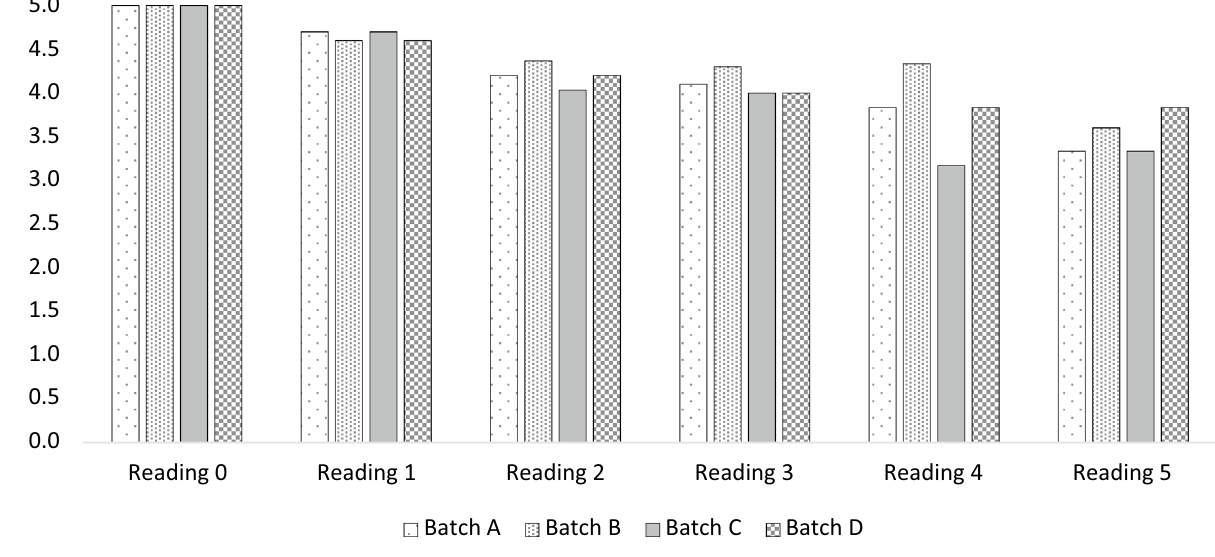
Figure 6. Weekly sensory evaluation of mango fruit exposed to four different treatments ( A negative control non-treated fruit; B PJ-WS-LE extract at 8 g L −1 was used to treat the fruit; C 1% chitosan was used to treat the fruit; D 8 g L −1 PJ-WS-LE extract embedded in 1% chitosan was used to treat the fruit) stored at 4 °C for 5 weeks.